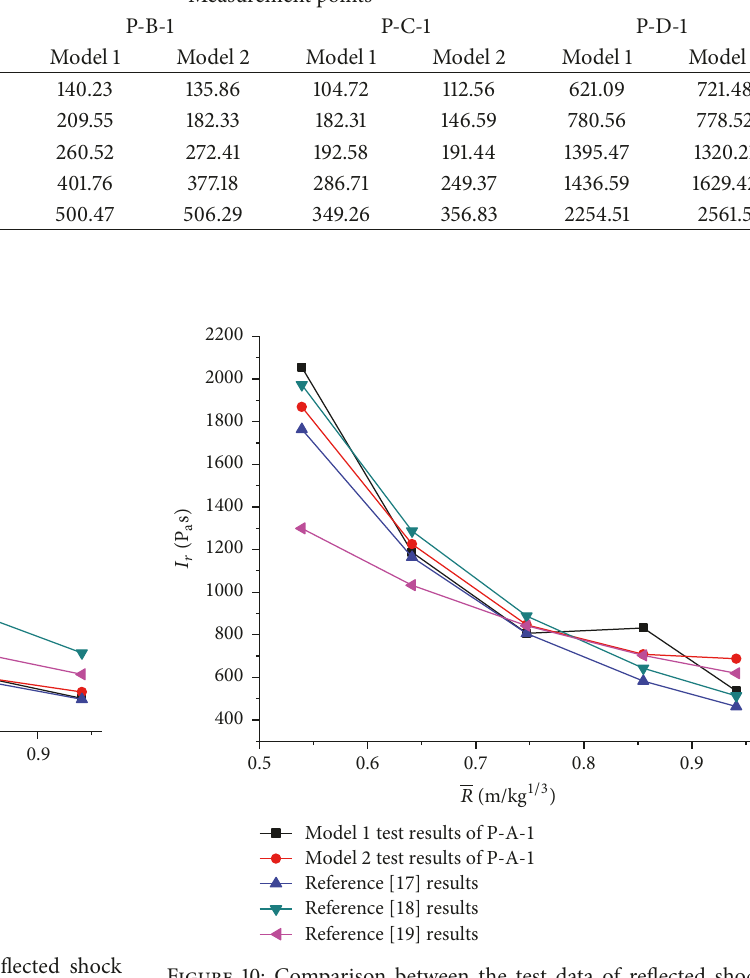
Figure 10: Comparison between the test data of reflected shock specific impulse and computed